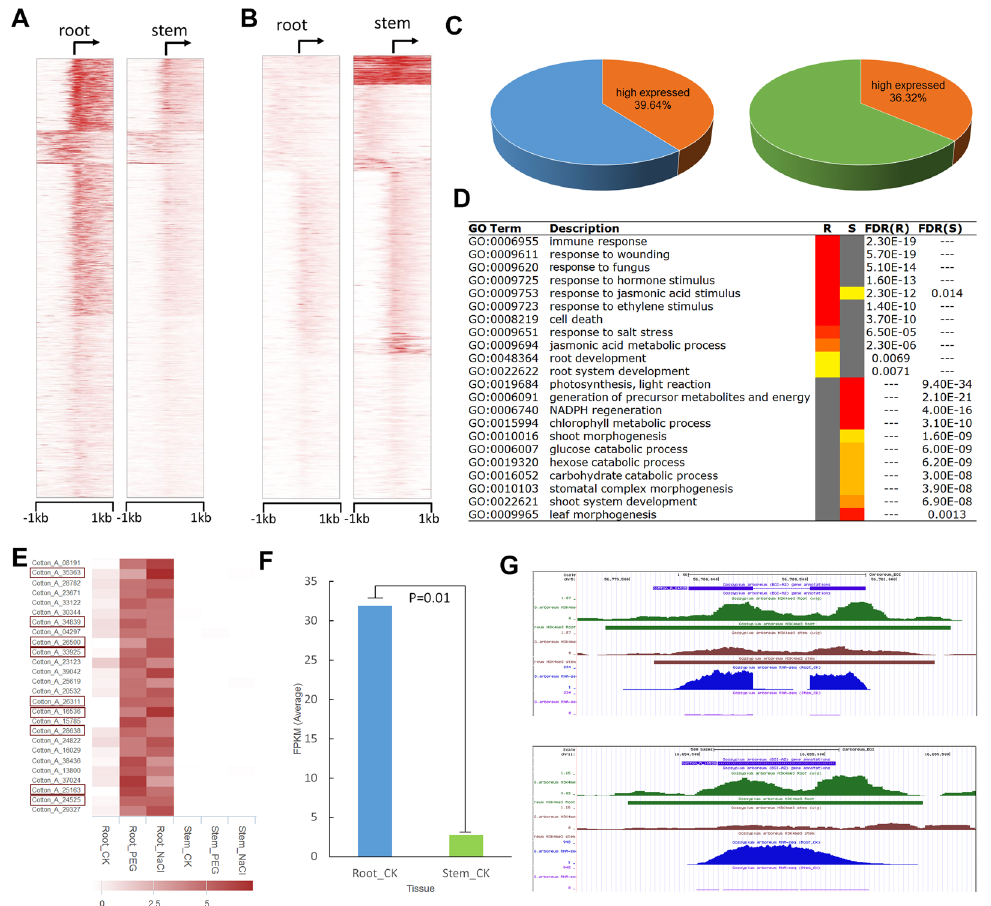
Figure 10. Modularized comparison of differential histone modification during development. Heatmaps for H3K4me3 around the TSSs of 4,871 root-up modification ( A ) and 1,608 stem-up modification ( B ) genes in G. arboreum . K-means were used to cluster them into four groups. For each gene, the histone modification intensities are displayed along –1-kb to 1-kb regions around the TSSs. The colour represents H3K4me3 levels. ( C ) 39.64% of the 4,871 root-up modification genes are highly expressed in root (left) and 36.32% of the 1,608 stem-up modification genes are highly expressed in stem (right). ( D ) GO enrichment results for genes having both high H3K4me3 modification and expression in root (R) and stem (S) are selected here. The red and grey boxes with “GO: 0006955” stand for root-up genes that are enriched significantly, whereas stem-up genes are not significant. ( E ) A heatmap of 26 gene expression profiles in root and stem. All the genes shown are involved in the co-expression network of Cotton_A_24525 (GaGSTU7). Genes highlighted with red rectangles have root-up H3K4me3 modification. ( F ) The average FPKM value of the 9 co-expression genes highlighted in ( E ) are compared to control root and stem tissues. ( G ) The H3K4me3 profiles in UCSC genome browser. Gene Cotton_A_24525 and its co-expressed gene Cotton_A_16536 with root-up modification are